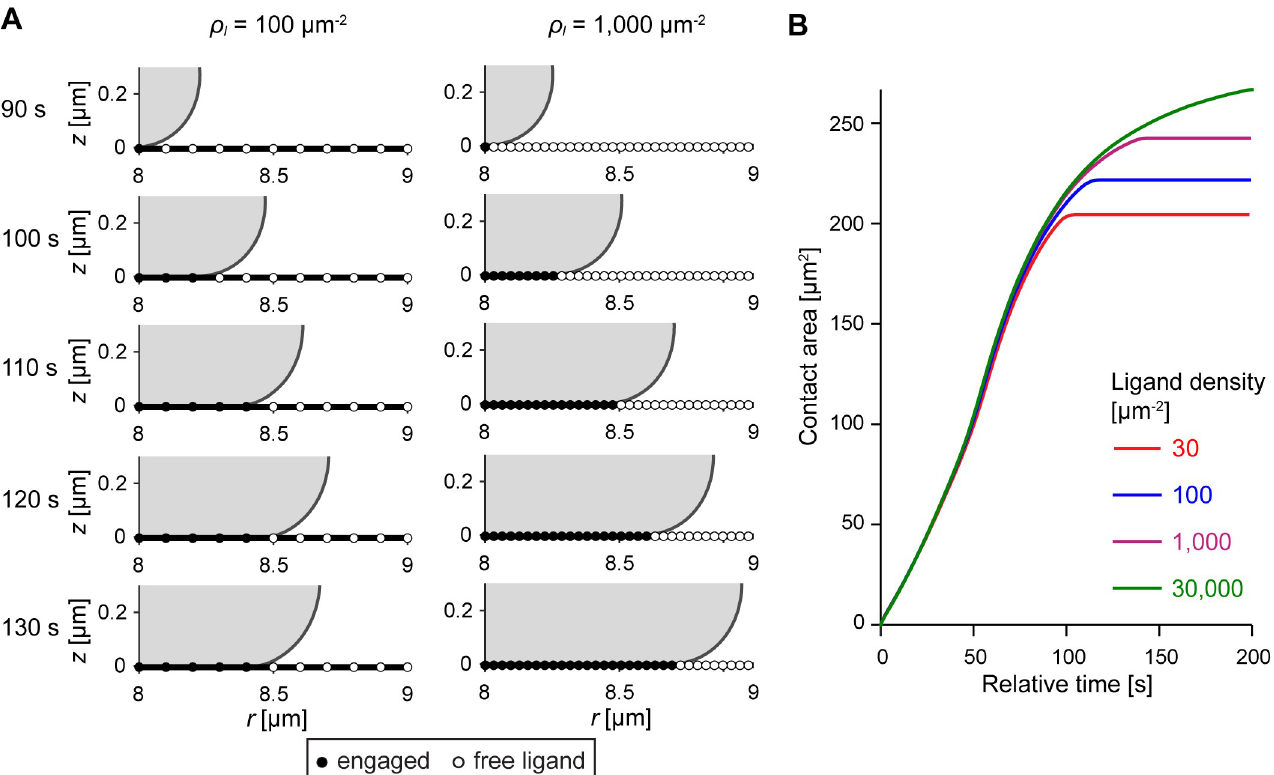
Fig 7. Predictions of the protrusive zipper model with discrete adhesion sites. (A) Two time series (times shown at the left) of simulation snapshots illustrate how the progression of the model cell’s leading edge is affected by the spacing of discrete adhesion sites. Unoccupied binding sites are depicted by empty circles, whereas filled circles indicate that the cell membrane is locally attached. (B) Contact-area-versus-time curves share similar slopes over three orders of magnitude of ligand density, but plateau at different maximum contact areas.